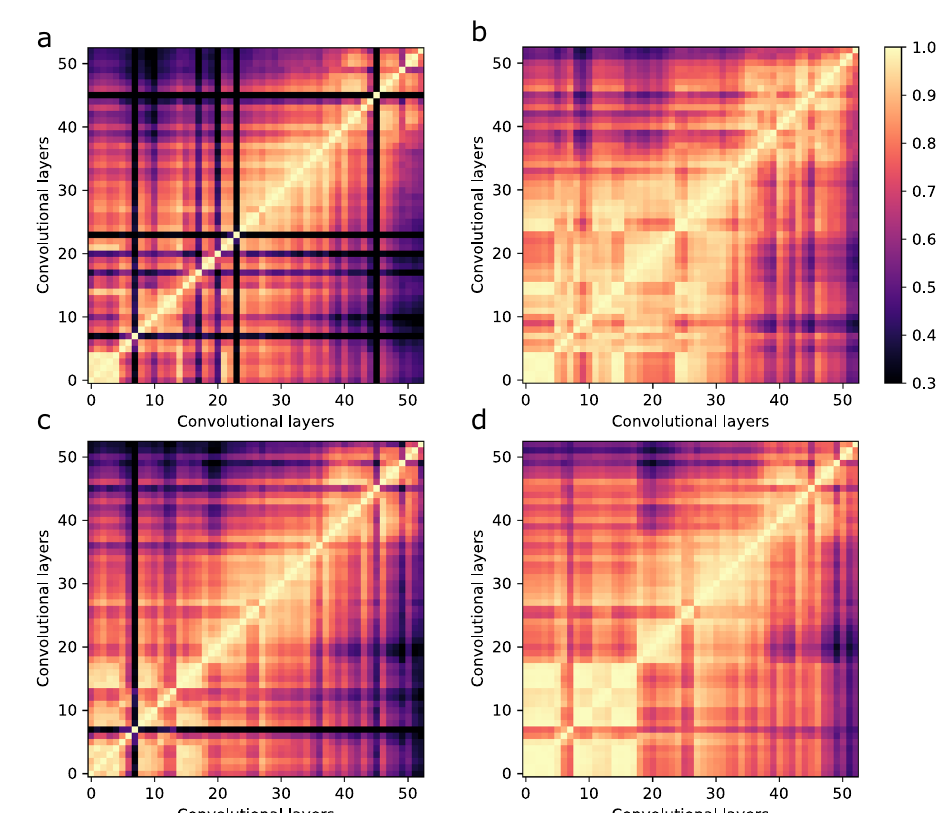
Fig. 7 Linear centered kernel alignment (CKA) reveals representations are in fl uenced by batch norms. To explore the learned hidden representations, the linear CKA between convolutional layers of the models was computed on the CheXpert test set: a model trained with a single batch norm in a conventional setting with real examples ( a ), a model trained with a single batch norm with real and adversarial examples ( b ), and a model trained with a dual batch norm with real and adversarial examples when the respective CKA was evaluated separately with the batch norm used for real ( c ) and adversarial ( d ) examples. It should be noted that the observed grid pattern in a was due to the residual connections in the ResNet architecture 39 . When employing adversarial training with a single batch norm, layers of the network seem to get more similar to each other, as visualized by the block-like structure arising from the high degree of similar neural activations in ( b ). This indicates, that the neural network loses complexity due to adversarial training which might contribute to a loss in performance. When employing a dual batch norm for original and adversarial examples respectively, the complexity of the network seems to be preserved (note the similarity between a and c ), when presented real examples using the fi rst batch norm, while simultaneously robustness to adversarial examples arises due to the same changes when employing the second batch norm ( d ) that the network from ( b ) underwent (note the similarity between b and d